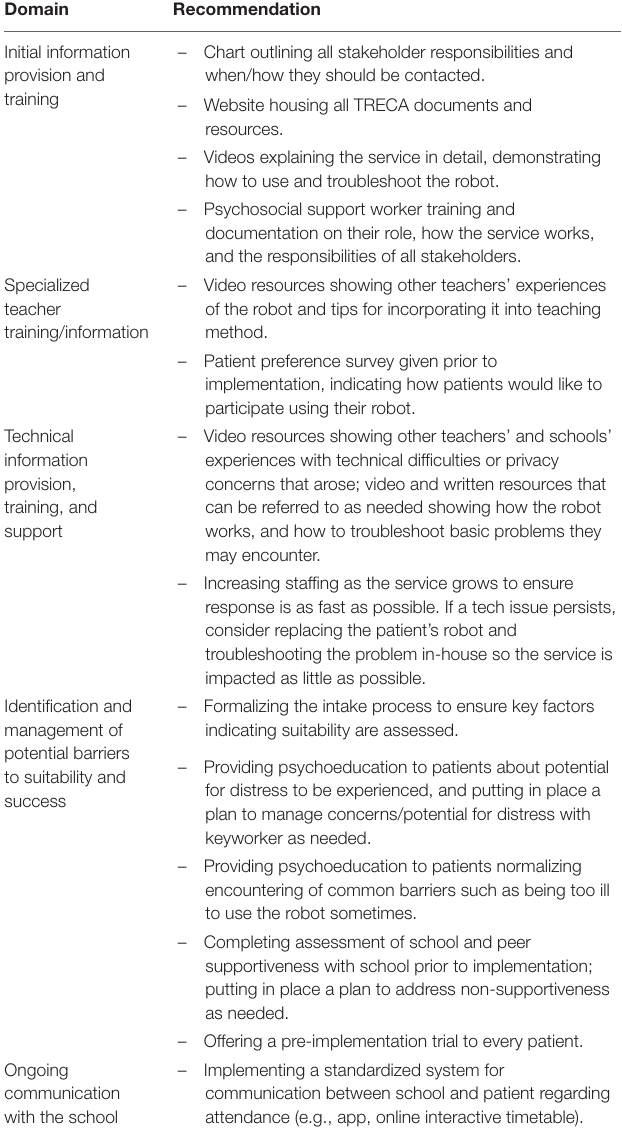
TABLE 3 | Recommendations for implementing a telepresence robot